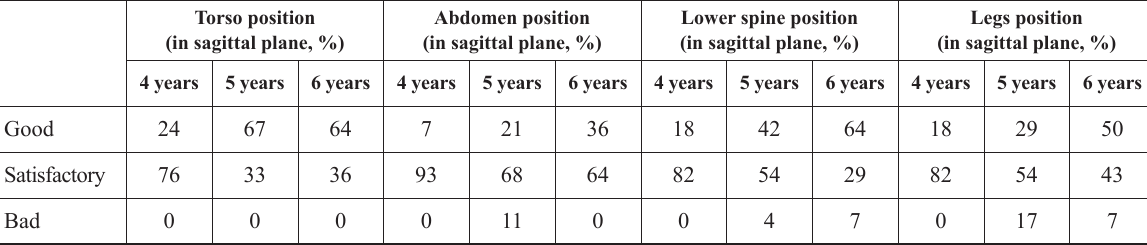
seconds on average, the abdomen – 16 seconds, and the Flamingo test result – 15